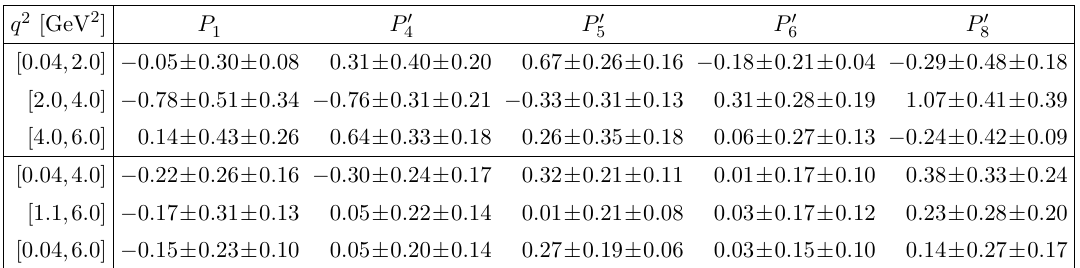
Table 2 . The values of F The uncertainties indicated are statistical and systematic, respectively.